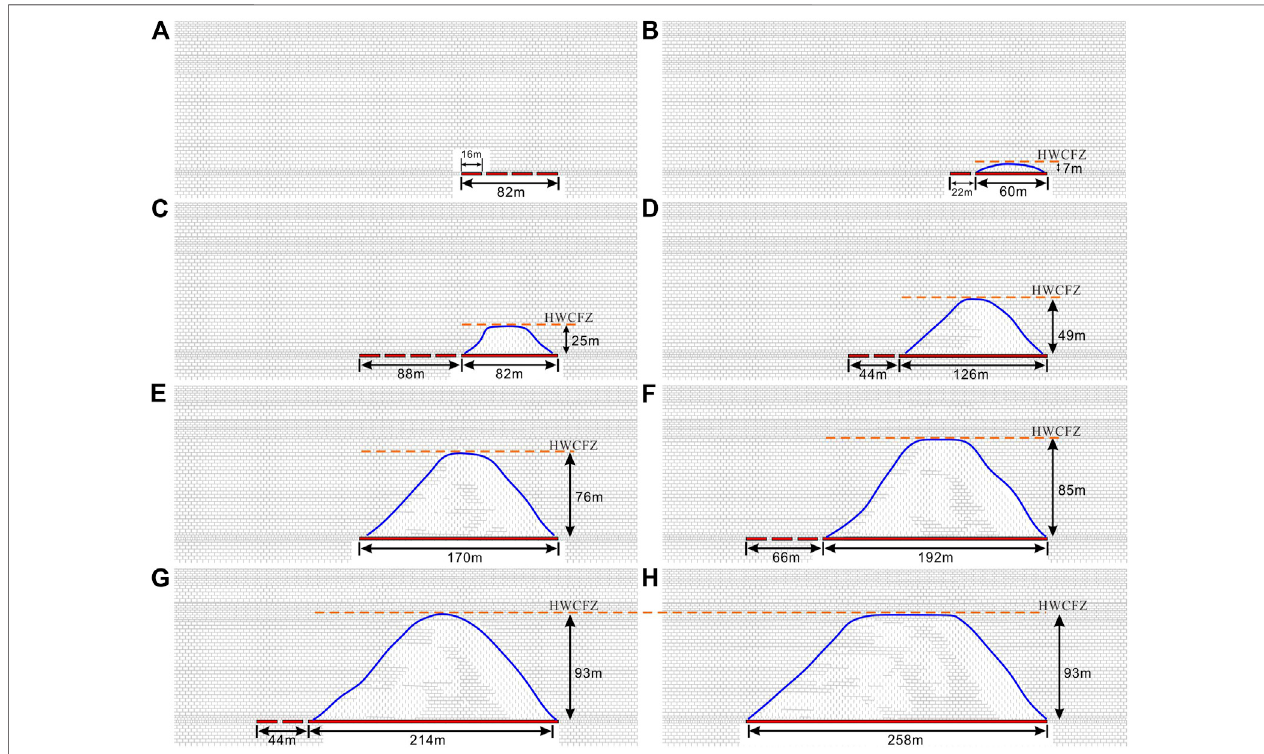
FIGURE11| Height ofthe WCFZasmining: (A) advancing16 mcontinuously, (B) advancing 60 m continuously, (C) advancing 82 mcontinuously, (D) advancing 126 m continuously, (E) advancing 170 m continuously, (F) advancing 192 m continuously, (G) advancing 214 m continuously, (H) advancing 258 m continuously.